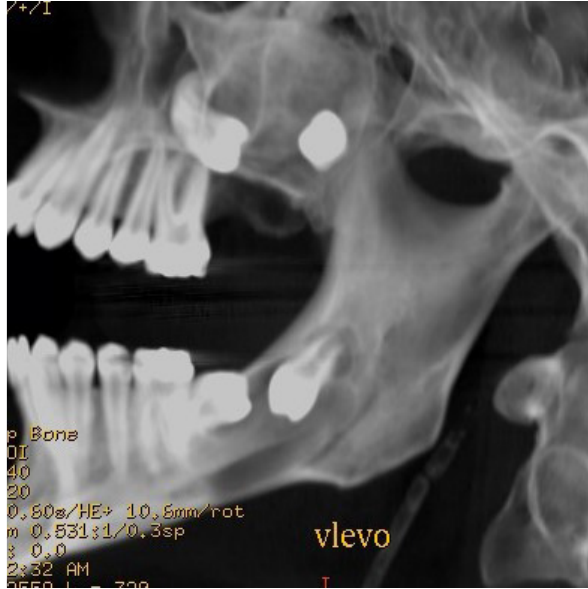
Fig. 3. Multiple syndromic keratocysts associated with retained teeth.